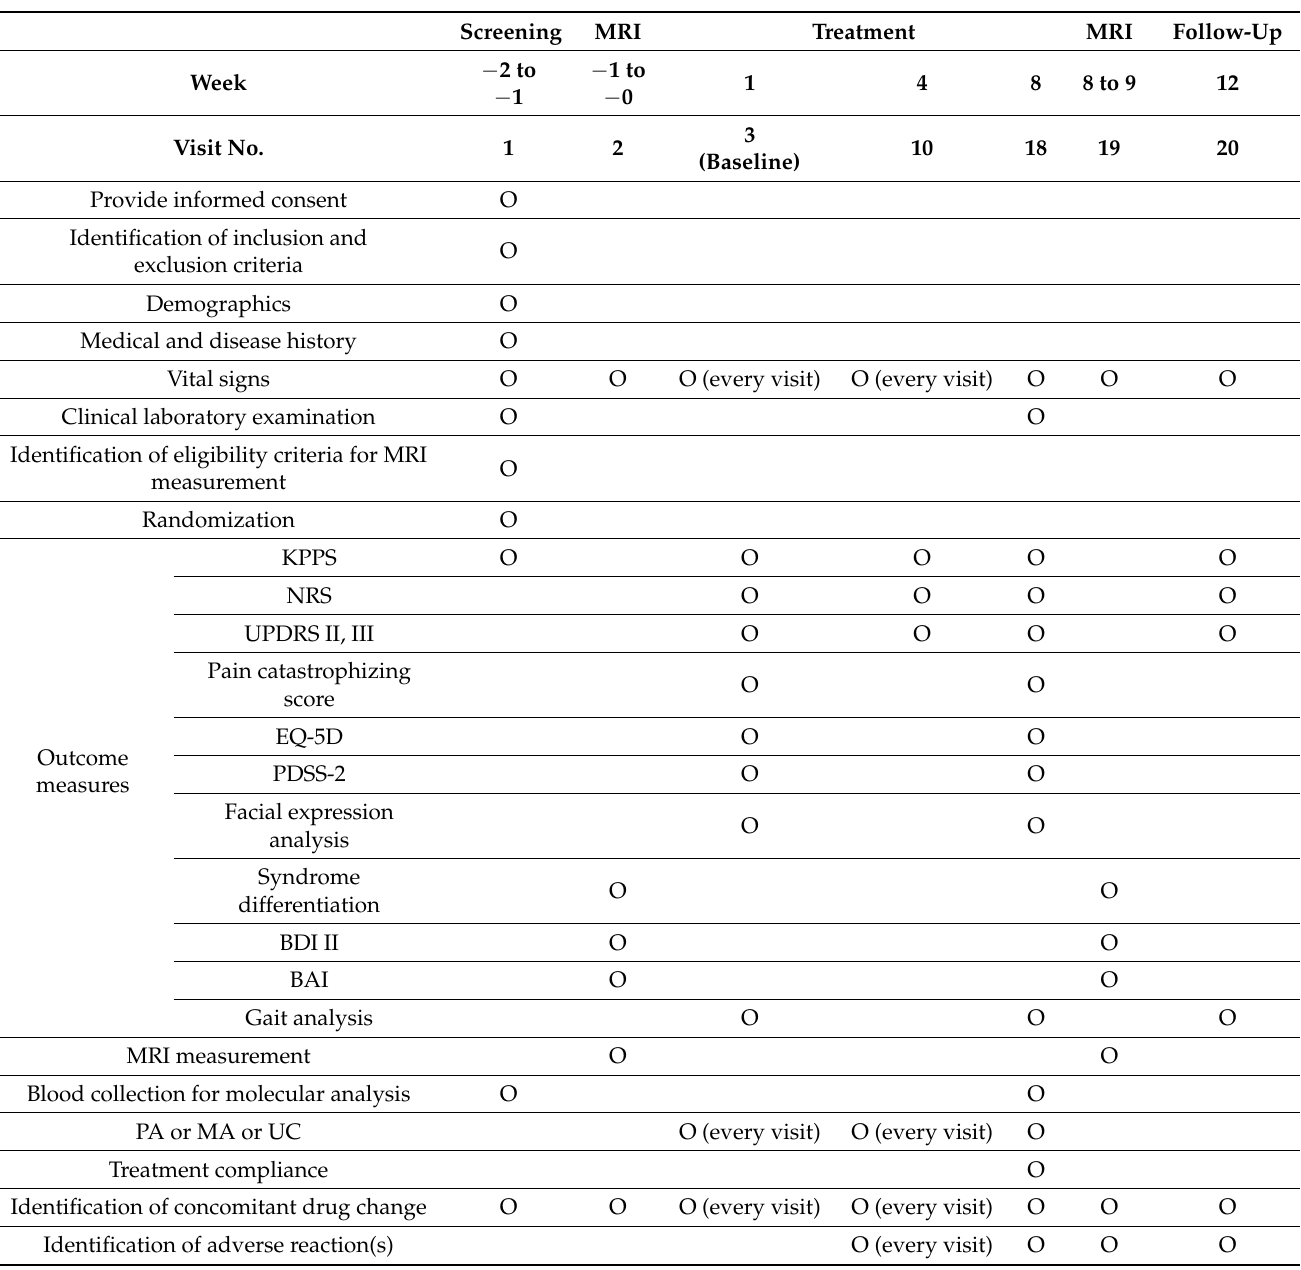
Table 2. Schedule of enrollment, clinical outcomes, and safety